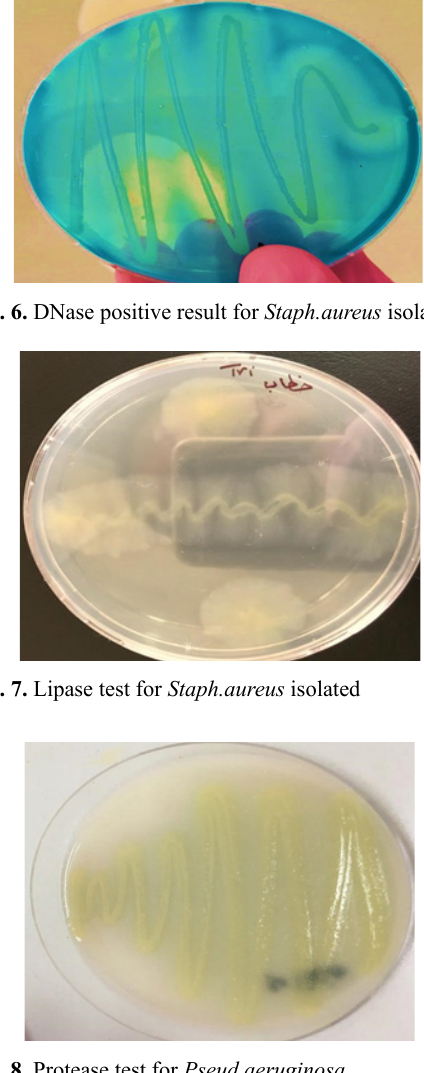
Fig. 8. Protease test for Pseud.aeruginosa